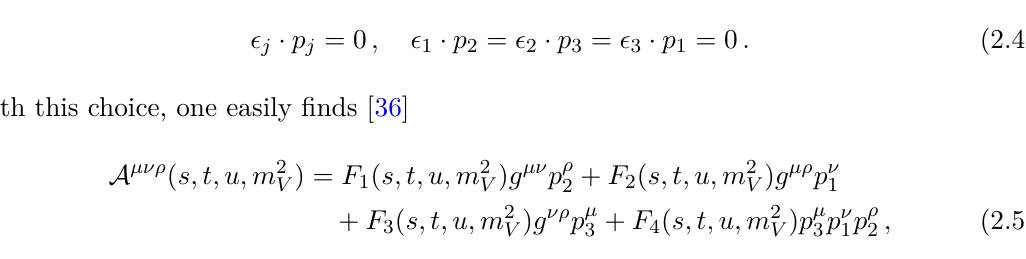
The scattering amplitude for this process depends on the three Mandelstam variables s = ( p + p ) 2 1 2